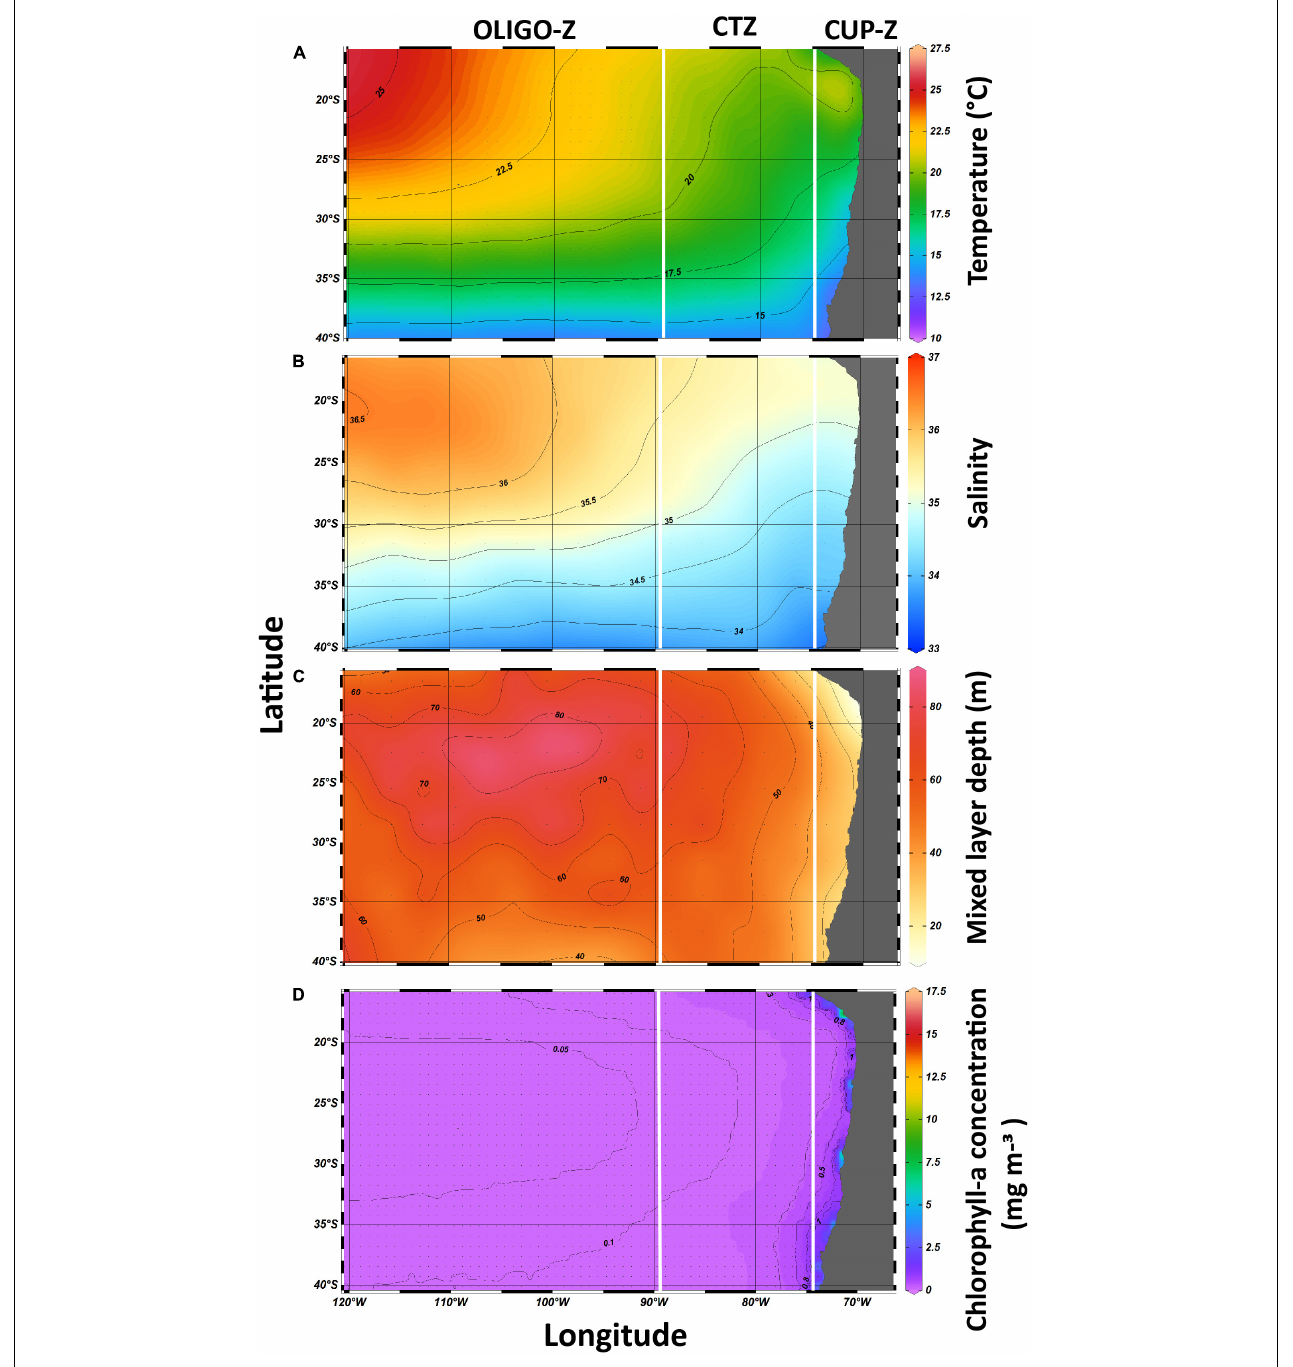
FIGURE 7 | Satellite-derived means of surface oceanographic conditions in the southeast Pacific from 2002 to 2015 for the three study areas defined as: coastal upwelling zone (CUP-Z), mesotrophic coastal transition zone (CTZ), and oligotrophic zone (OLIGO-Z). (A) temperature, (B) salinity, (C) mixed layer, and (D) Chlorophyll-a